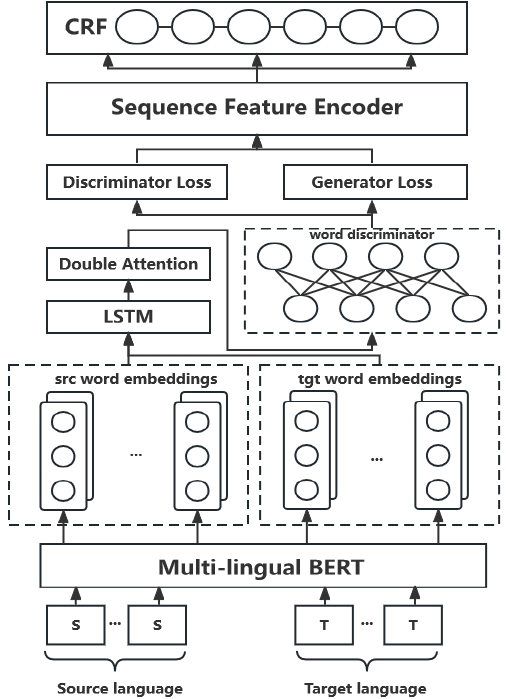
Figure 2. Model Figure 2. Model Structure.